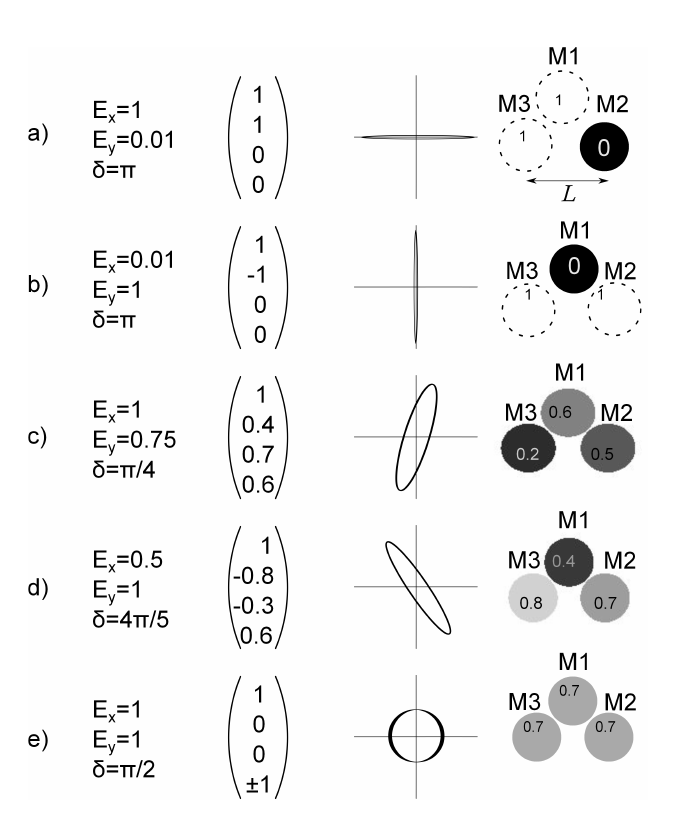
Figure 4. Sample patterns for various polarization cases. The first column shows the incident electrical field of two plane waves ( E and E ) and the phase difference δ . The x y second column shows the Stokes matrix. The third column has a graphic of the ellipse of polarization. The last column gives the simulated pattern of the Stokesmeter for the polarization case with normalized intensities. Black corresponds to the poor signal of the p-polarization (0) and white (1) to the full signal. The distance L depends on the wavelength. A larger wavelength means a longer distance between